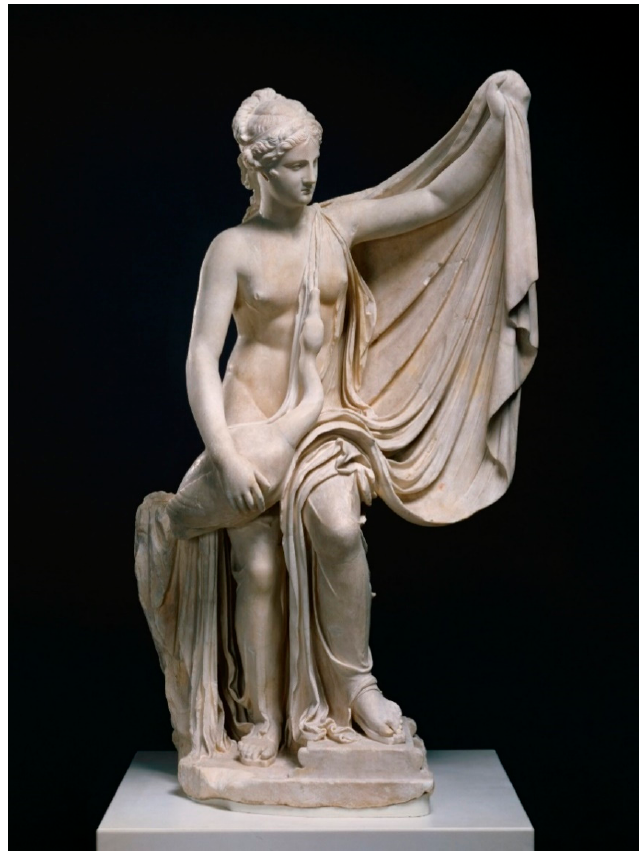
Figure 10. Statue of Leda and the Swan , 1st century CE, Marble. 70.AA.110. The J. Paul Getty Museum, Villa Collection, Malibu, California. (Digital image courtesy of the Getty’s Open Content Program).